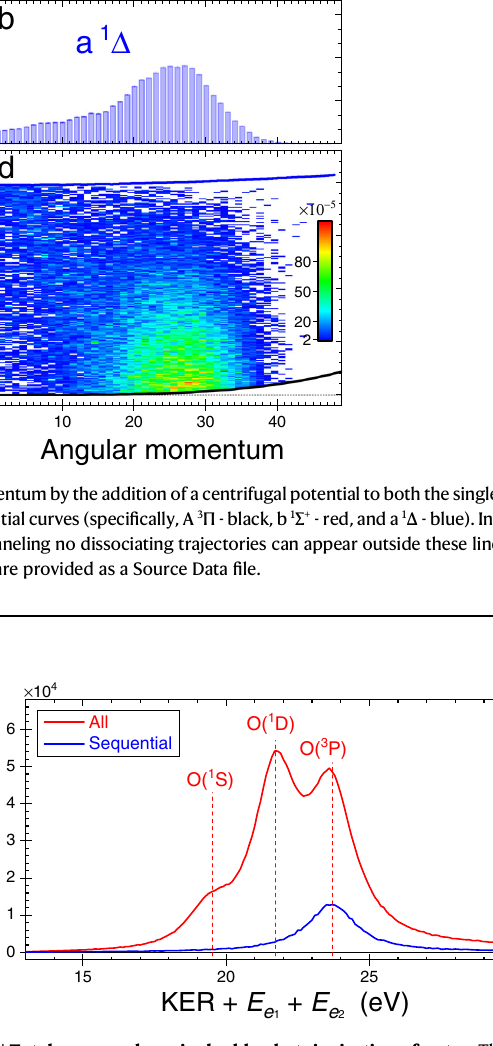
Fig. 4 | Total energy release in double photoionization of water. The measured distribution, N (KER+ E e + E e ). The vertical lines indicate the expected energy of 1 2 eachD + +D + +Odissociationlimit,whicharelabeledbythe fi nalstateoftheoxygen atom and shifted downby 0.4eV(seetext). Notethat sequentialfragmentationvia OD + II correlates only with the D + +D + +O( 3 P) dissociation limit. The broad energy distribution,clearlyvisibleinthesequentialbreakup,ismainlyduetotheextended target along the light-propagation direction, energy resolution, and the spread in center-of-mass momentum that cannot be corrected for because the neutral oxy- gen fragment is not detected but rather evaluated from momentum conserva- tion. Source data are provided as a Source Data fi